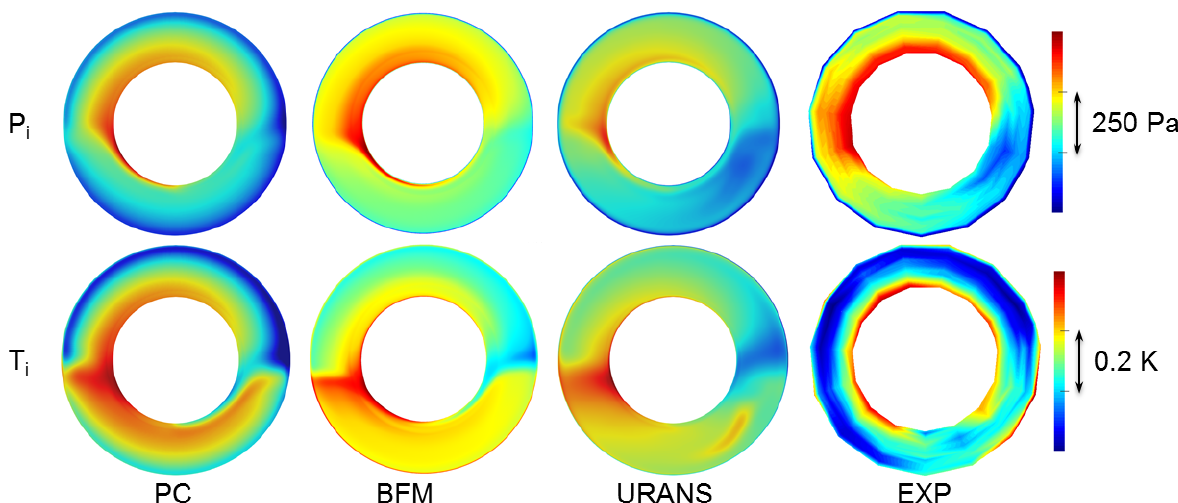
Figure 13. Total pressure ( top ) and total temperature ( bottom ) downstream of the